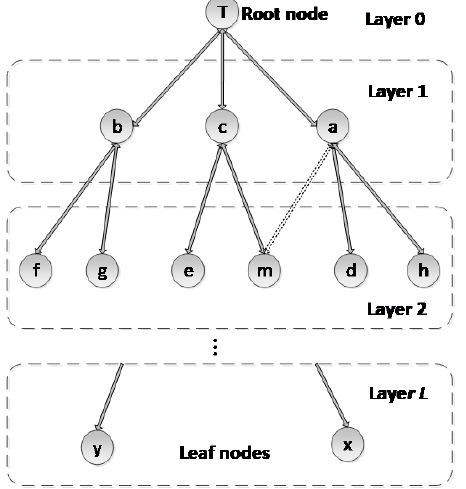
Figure 2. The network